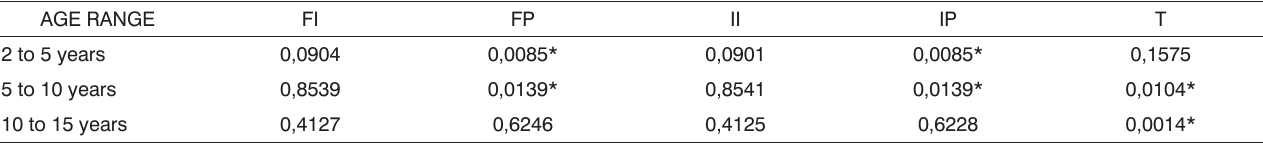
Table 7. Significance by variable in the three consistencies for the same age range (females) AGE